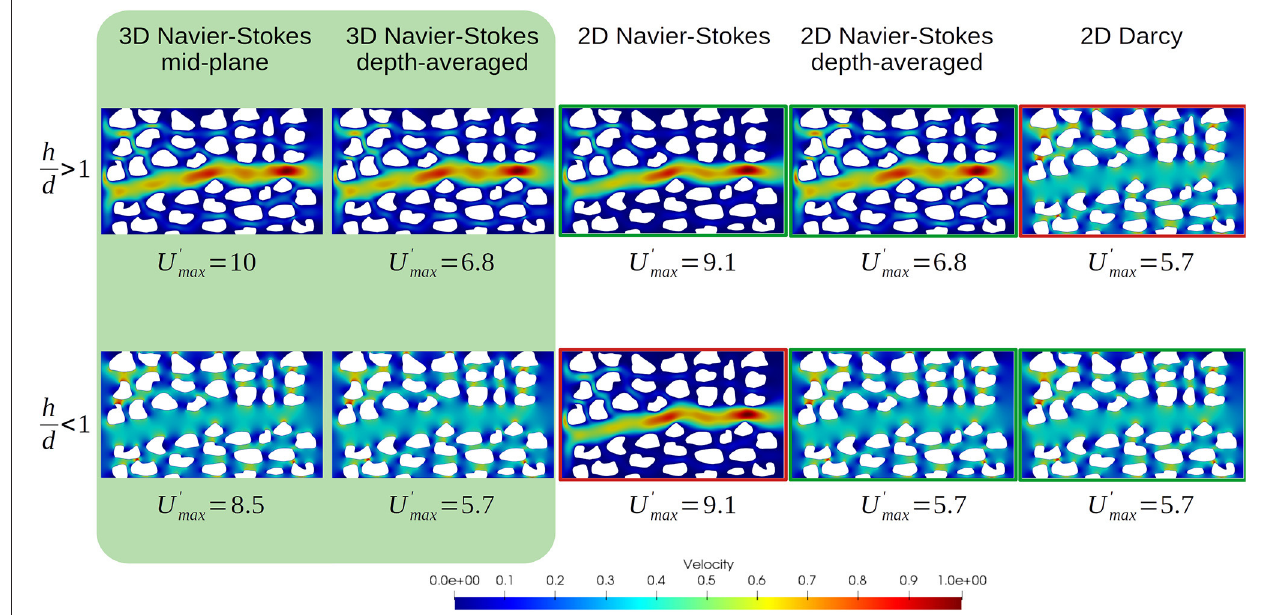
FIGURE 2 | Single-phase flow simulations using 3D, 2D, and 2D-depth-averaged models for different aspect ratio between the micromodel thickness, h and the smallest pore-throat, d . The computational domain is gridded with 1.4 × 10 5 cells for the 2D cases and 11.4 × 10 5 × 10 for the 3D cases. The typical pore-throat size is d typ = 4 × 10 − 3 m, the largest is d large = 12 × 10 − 3 m and the smallest is d = 0.5 × 10 − 3 m. We used two different depth thickness, namely h = 10 − 2 m and h = 10 − 4 m. Simulations are performed with OpenFOAM. For each simulation, the velocity profile is normalized by the maximum value, and we indicate the maximum > 1, 2D Navier-Stokes simulations tend toward the mid-plane 3D Navier-Stokes solution and 2D Darcy is far from the value normalized by the inlet velocity. If h d < 1, 2D Darcy captures the 3D reference solution whereas 2D Navier-Stokes breaks down. The 2D depth-integrated Navier-Stokes model reference solution. If h d captures the 3D flow behavior regardless the micromodel